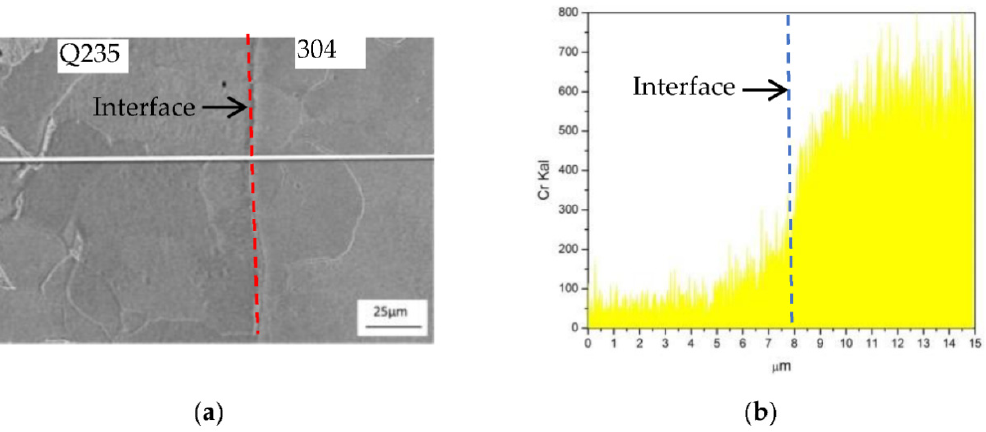
Figure 4. Results of the line scanning for chromium across the bonding interface ( a ) The image of line scanning. ( b ) The distribution of chromium across the interface in a region of 15 μ m.